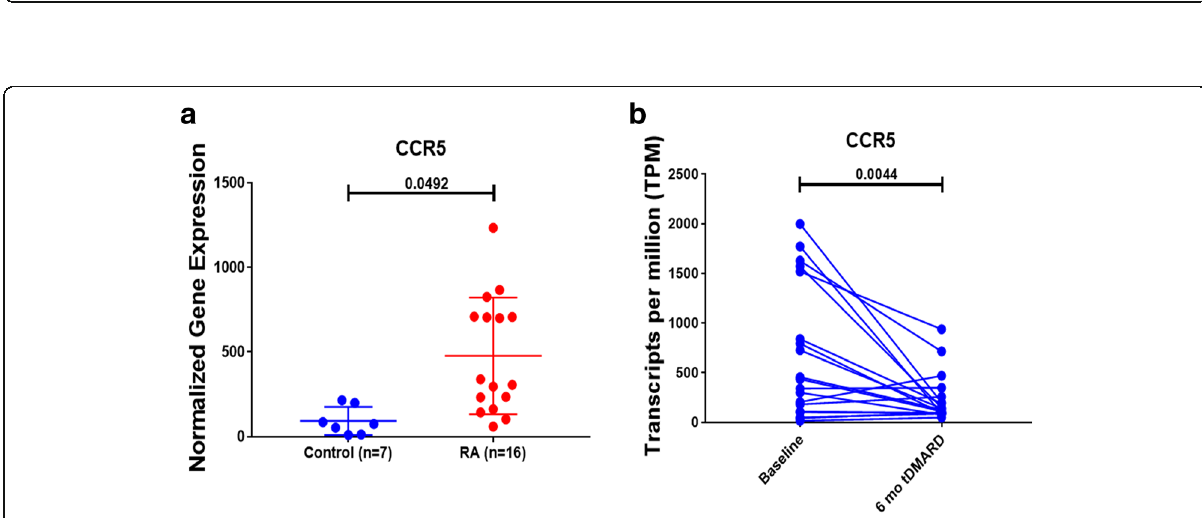
Fig. 5 CCR5 expression in synovial biopsies of RA and control and CCR5 expression at baseline and after six months of tDMARDs treatment. The expression of the chemokine receptor was searched in a microarray dataset (GSE77298) of synovial biopsies of RA and healthy controls. A paired T-test was used for